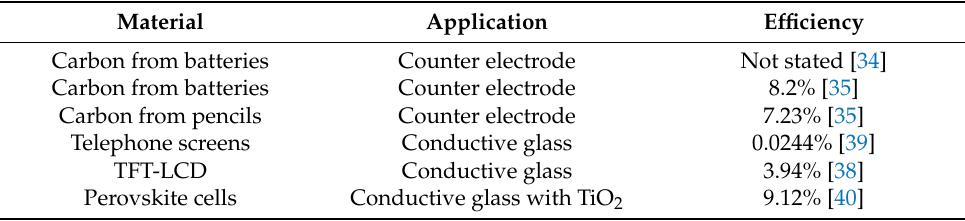
Table 2. Overview of the recycled material used and efficiencies achieved.